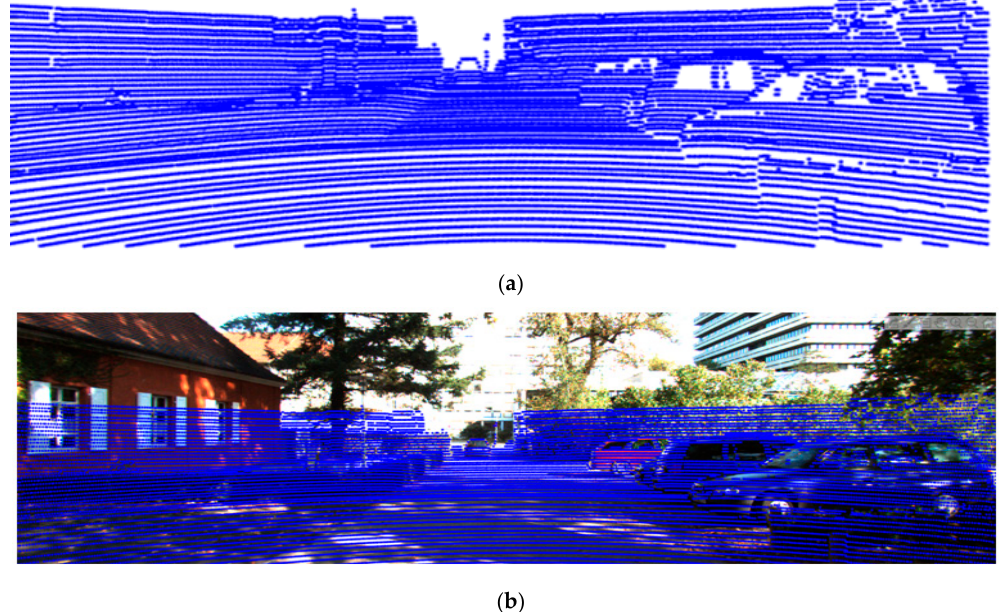
Figure 6. Projection of PCD on an image plane ( a ) PCD converted to pixel coordinates; ( b ) PCD projected on an image.